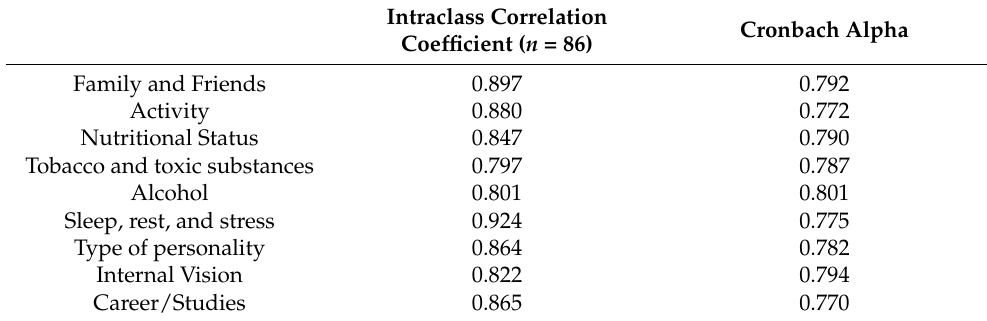
Table 3. Reliability of the questionnaire.